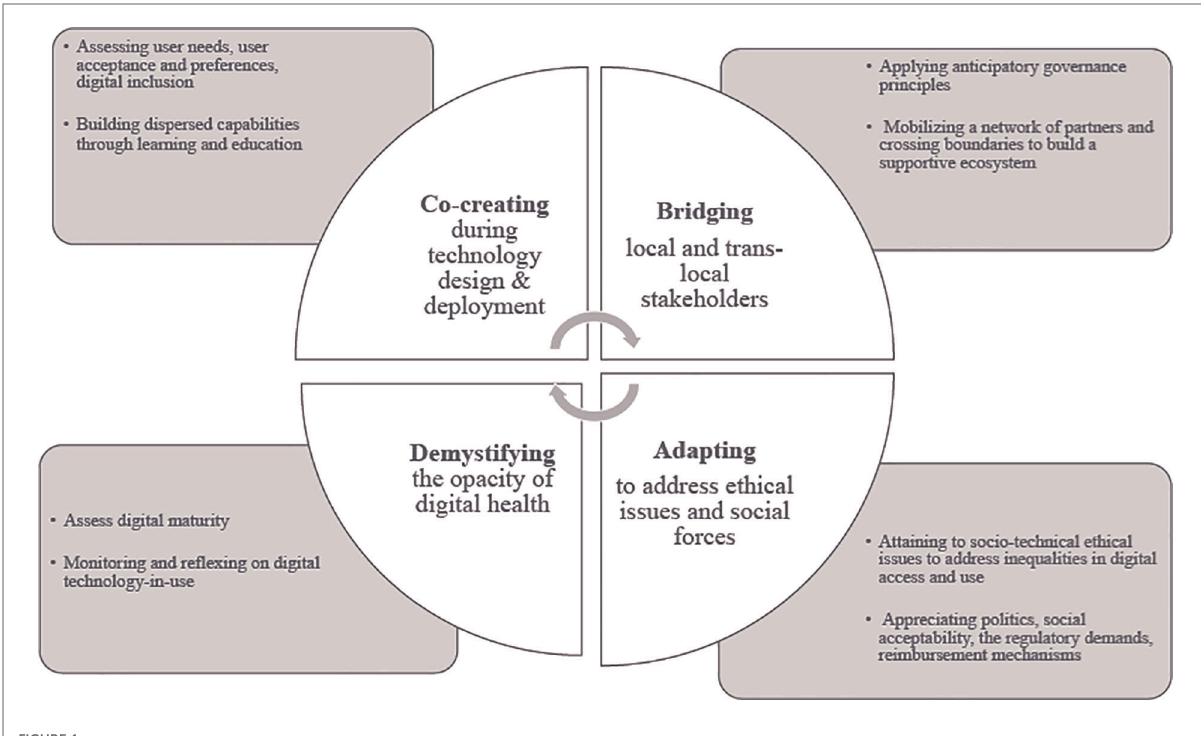
FIGURE 1 Themes on digital health